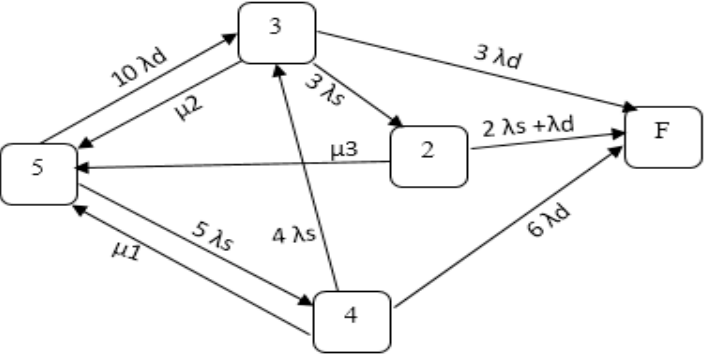
Figure 2. Penta modular redundancy (5MR) Markov model.